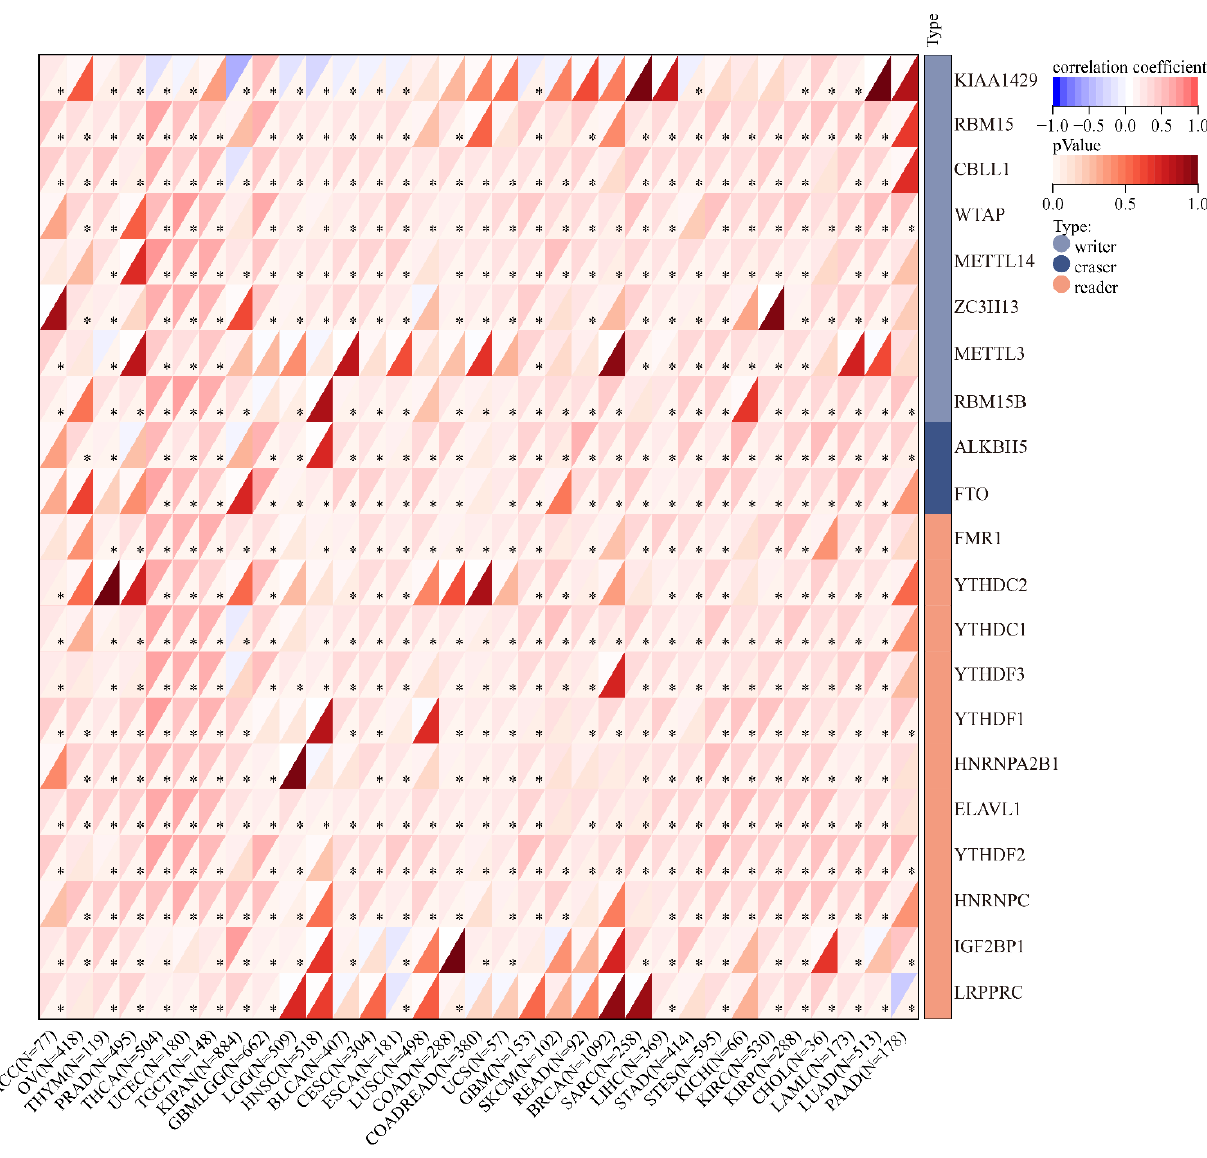
Figure 10. Relationship between SLC2A1 expression and RNA m6A-methylation-related genes in pan-cancer (*, p <